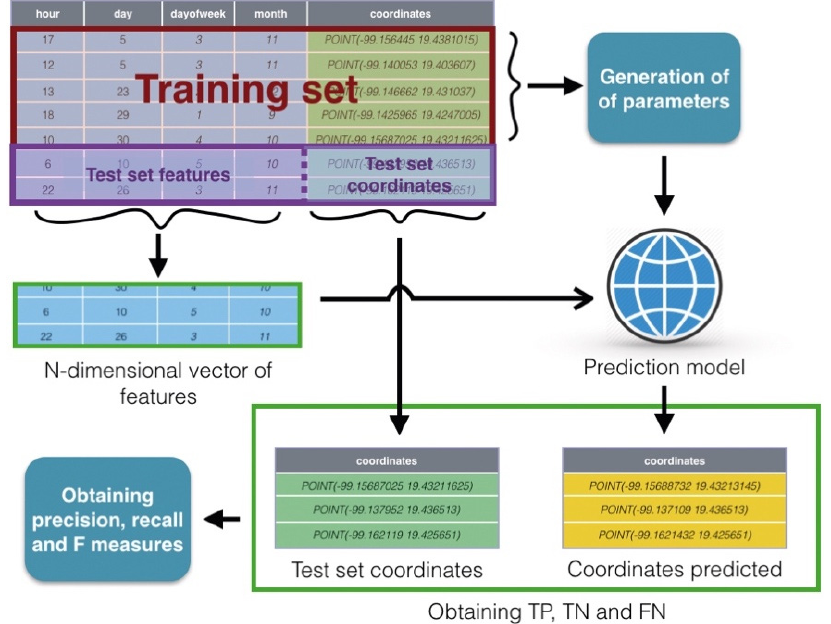
Figure 9. A general schema for the empirical testing of the prediction model.